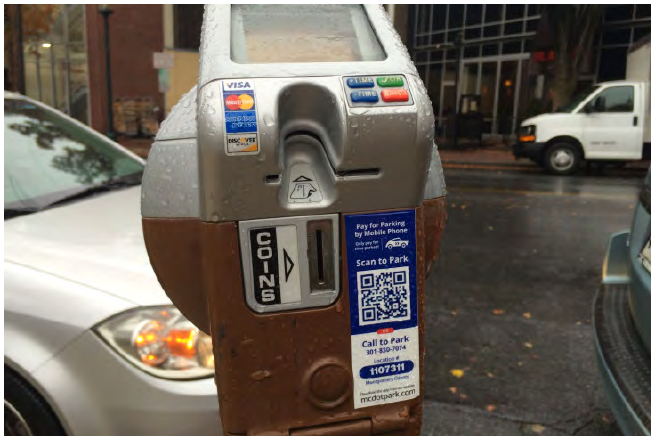
Figure 8. One of the new smart meters in Bethesda. (Lannelli,2015).